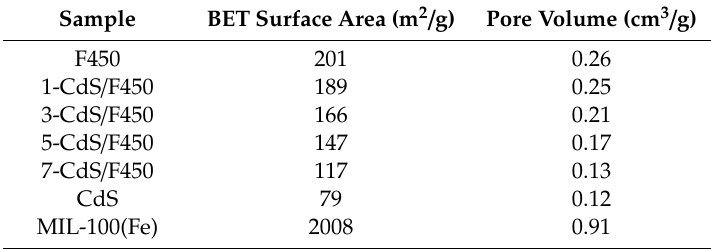
Table 2. The BET surface area and pore volume of F450, CdS, MIL-100(Fe) and X–CdS / F450